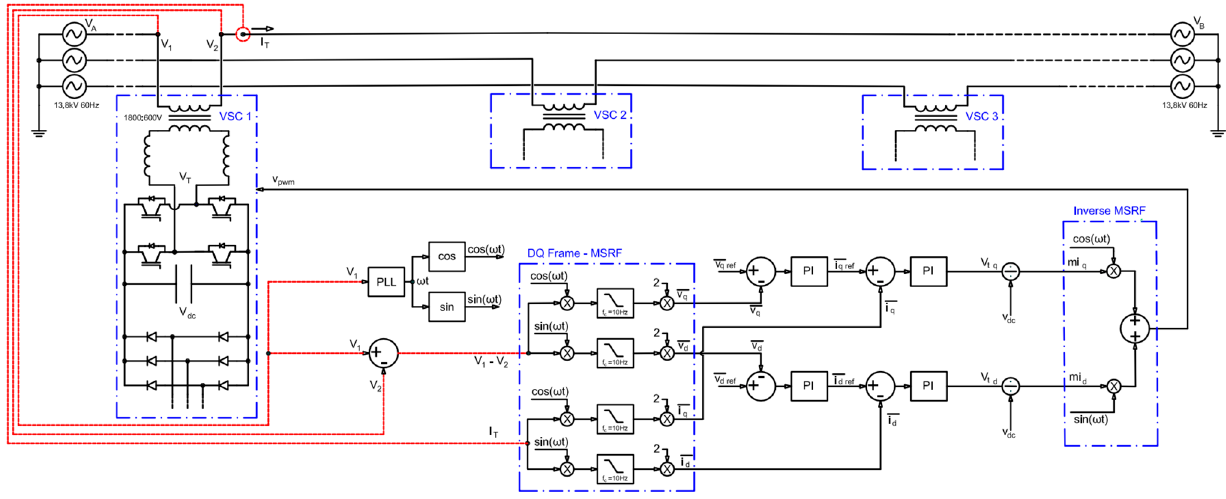
Figure 1. Modular three-phase series VSC connecting two feeders and the control system.